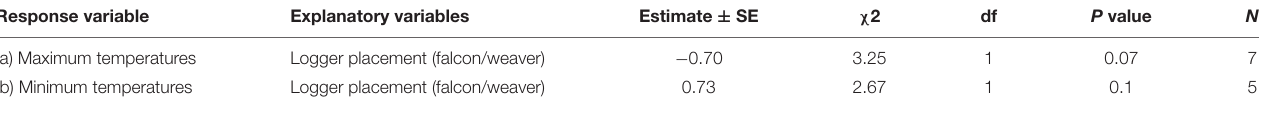
TABLE A2 | Linear mixed models comparing the maximum and minimum temperatures in falcon and weaver